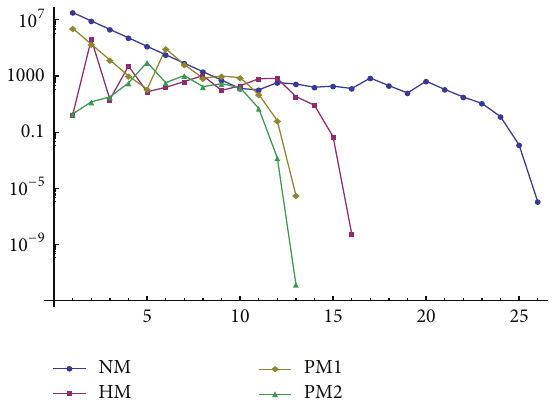
Figure 3: Convergence history versus number of iterations for different methods in Example